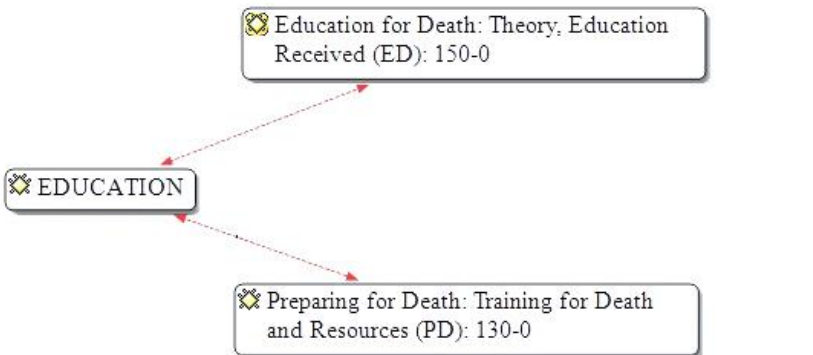
Figure 1. Death and preparation for death.